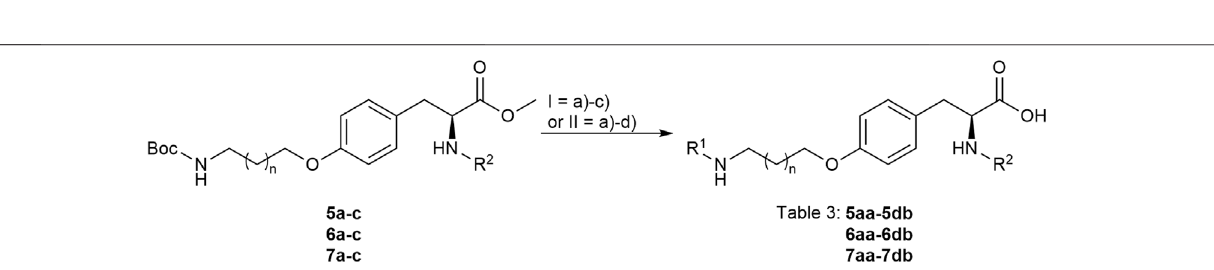
FIGURE 5 | Attachment of the guanidino mimetics giving the fi nal RGD mimetics 5aa-7cd. Reagents and conditions: a) 4 M HCl in dioxane, DCM, RT; b) 2- methylthio-2-imidazoline (DHI) or 2-bromopyrimidine (Pyr/THP), triethylamine, methanol, 80 ° C, o.n.; c) LiOH, water, methanol, RT; and d) Pd/C, H 2 , AcOH, water, methanol, RT,